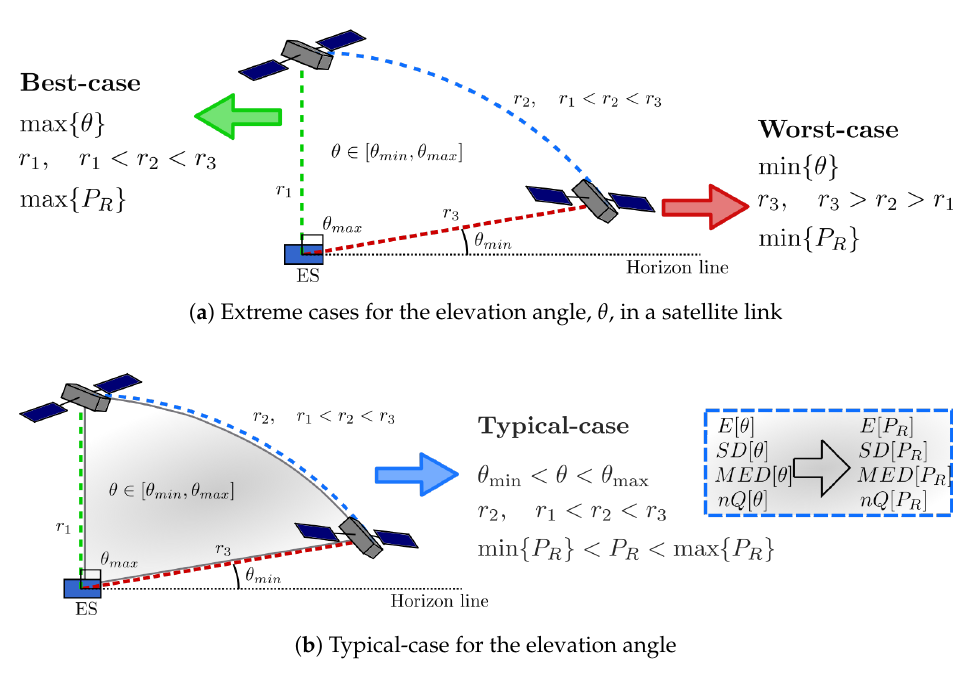
Figure 1. Elevation angle cases for LEO satellite systems: ( a ) The values of θ min and θ max are usually related to the best and worst case of the received power, P R , at an ES; nonetheless, those cases are rare and represent the extremes of θ . ( b ) The elevation angle of a LEO satellite system as observed from an ES is always-varying; then, it is more convenient to analyze its behavior through statistical